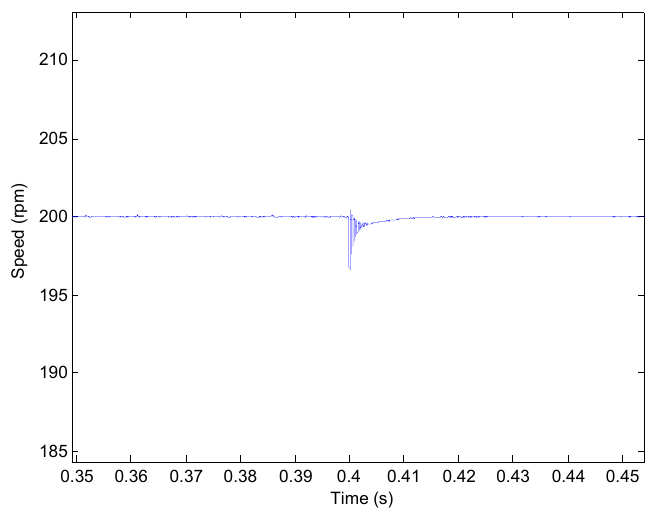
Figure 9. Zoomed-in revolution speeds of the motor using ADRC.